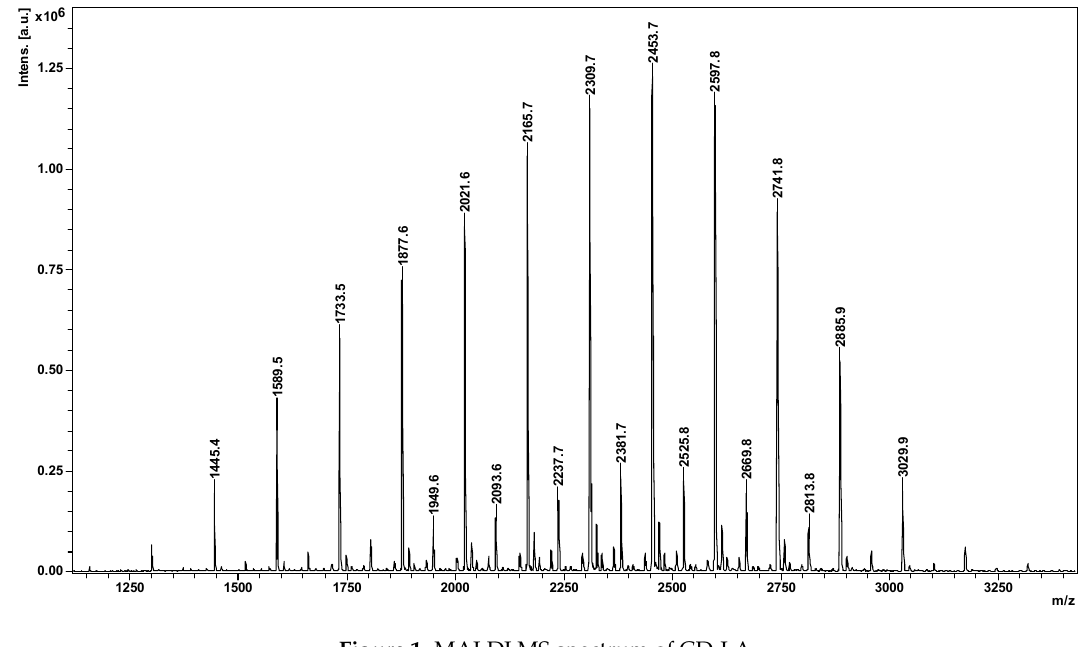
Figure 1. MALDI MS spectrum of CD-LA.